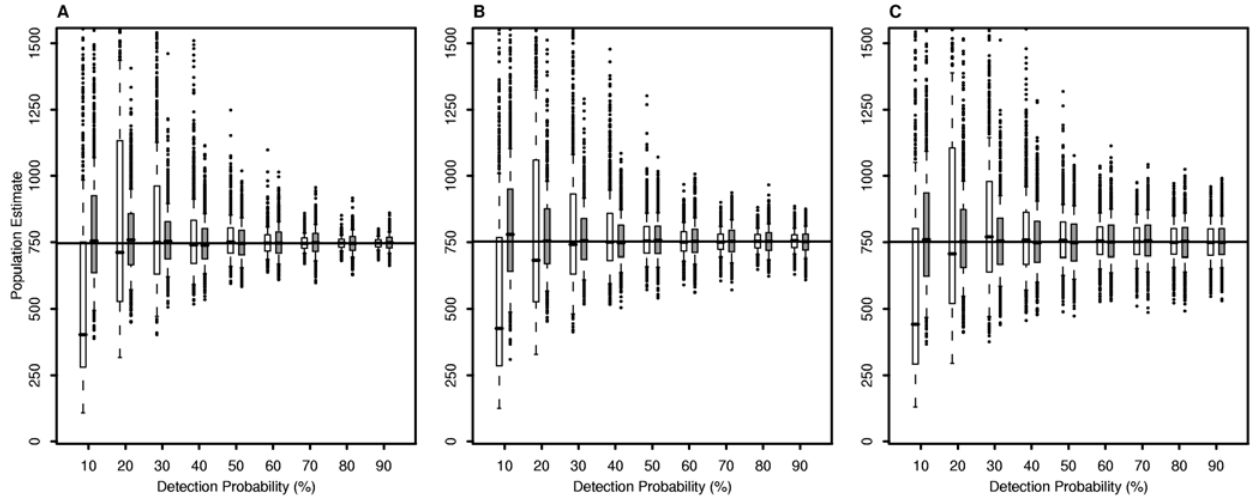
Figure 2. Population estimates for varying levels of population clustering. Population size was estimated using the double sampling and double observer methods for 1,000 simulations each for the low, moderate, and high clustered populations (Panels A, B, and C, respectively) with the survey proportion at 50%. White indicates the double observer method; gray indicates the double sampling method. Horizontal lines show true population sizes. The double observer method yielded more variable population estimates than the double sampling method for detection probabilities below 50% regardless of population clustering.